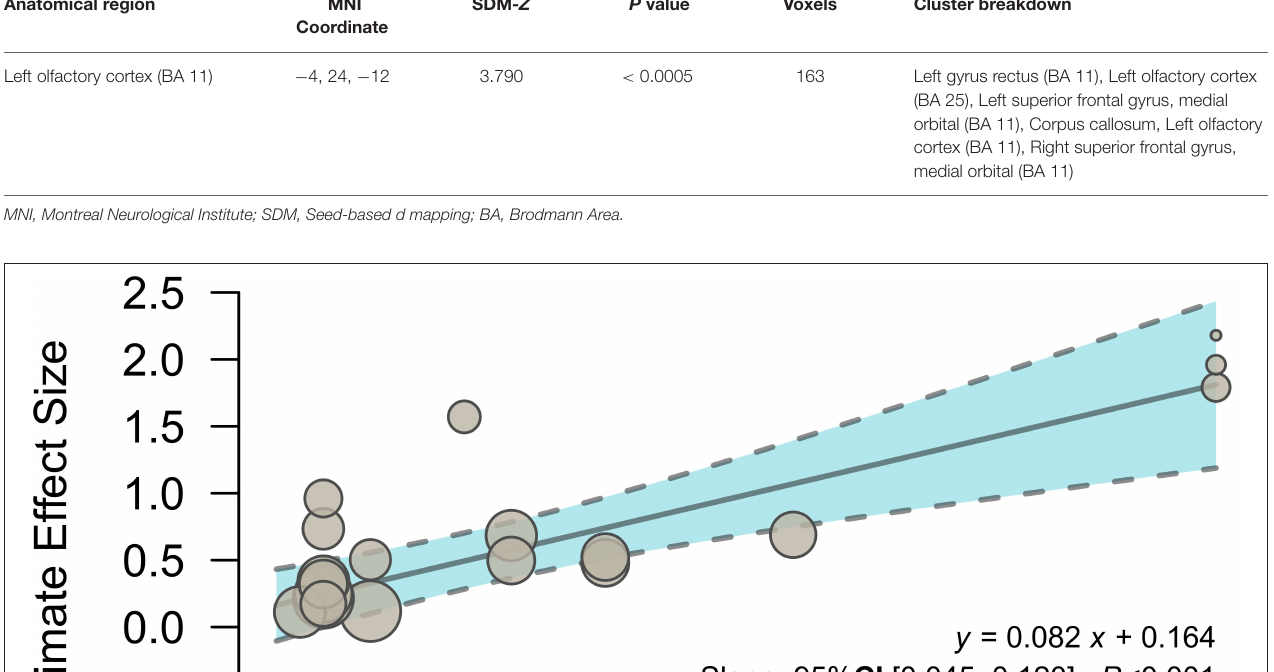
TABLE 3 | The brain region related to needle retention time. Anatomical region